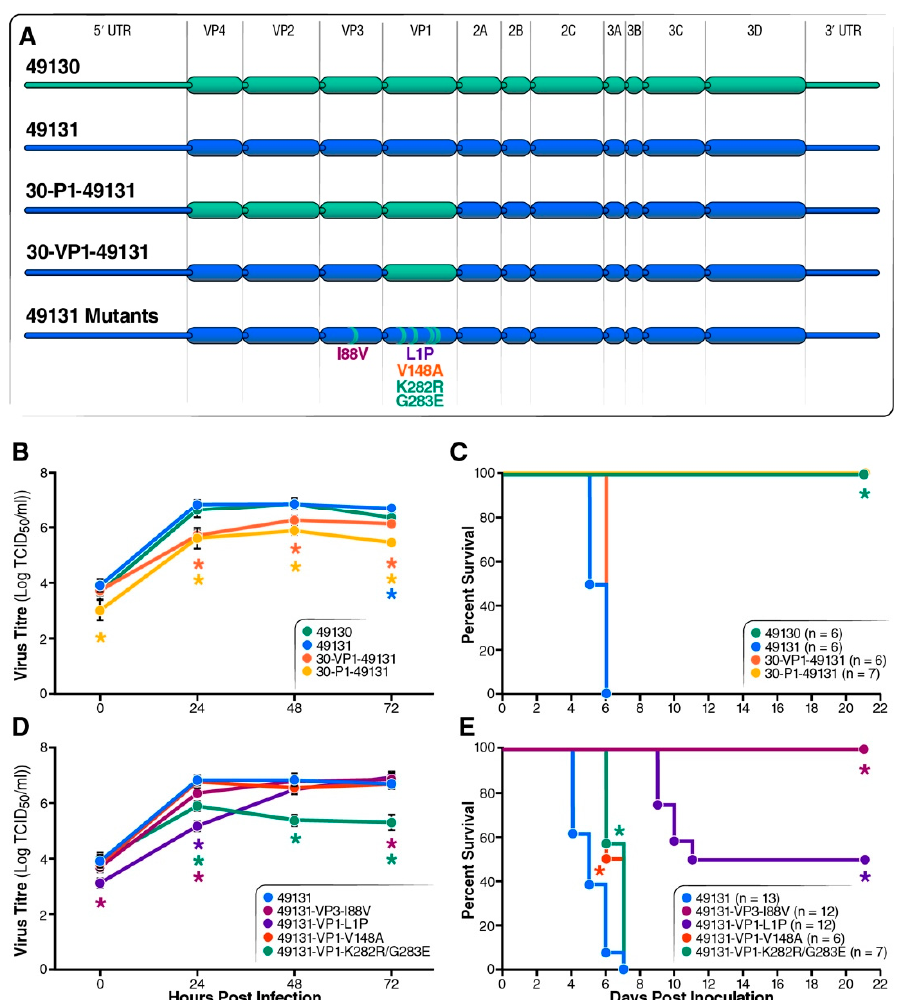
Figure 5. Validation of the conserved amino acid changes in structural proteins on replication and virulence of EV-D68. Asterisks represent significant difference as compared with 49131. ( A ) Representation of the gene composition for viruses carrying swapped VP1 or P1 gene and amino acid substitutions in the structural gene. Strain 49131 was used as backbone to generate these recombinant viruses. Amino acid changes VP3-I88V, VP1-L1P and VP1-V148A were introduced into 49131